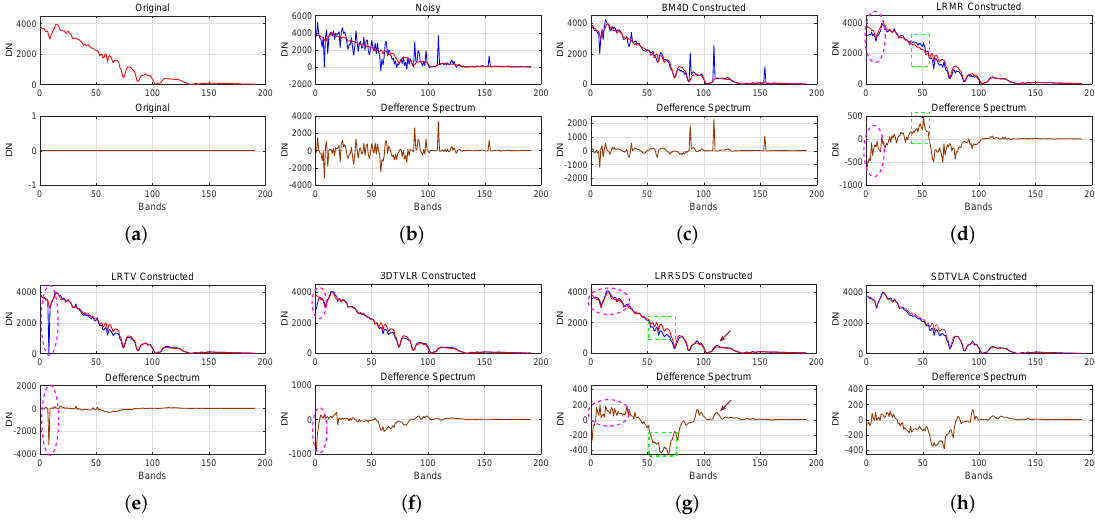
Figure 7. Reconstructed spectrum of the pixel at the location of ( 110,206 ) in the simulated WDC dataset. ( a ) Noisy-free spectrum; ( b ) noisy spectrum; ( c ) BM4D; ( d ) LRMR; ( e ) LRTV; ( f ) 3DTVLR; ( g ) LRRSDS; ( h )